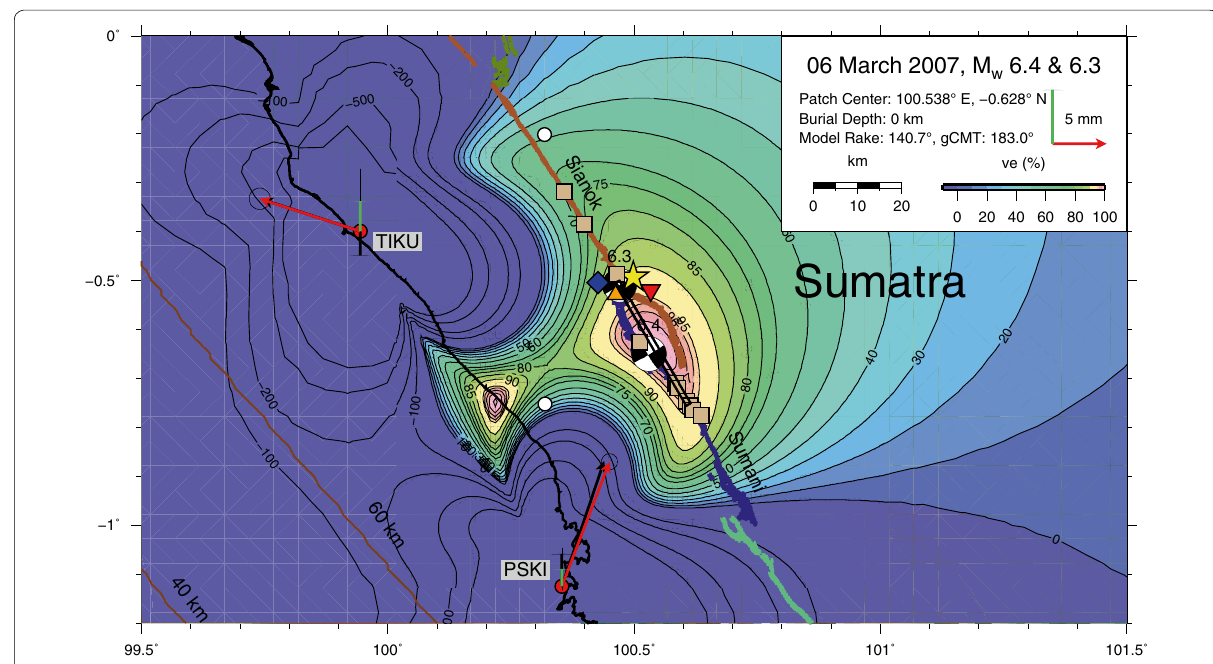
Fig. 4 Grid-search results for the 6 March 2007 M w 6.4 and 6.3 Sumatran fault earthquake doublet when the burial depth is fixed at surface. Tan squares show 10 localities where twin-surface ruptures associated with this event were documented (Daryono et al. 2012). The final patch is located over the pull-apart basin between the Sianok (dark brown) and Sumani (dark blue) segments to the northwest and southeast, respectively.